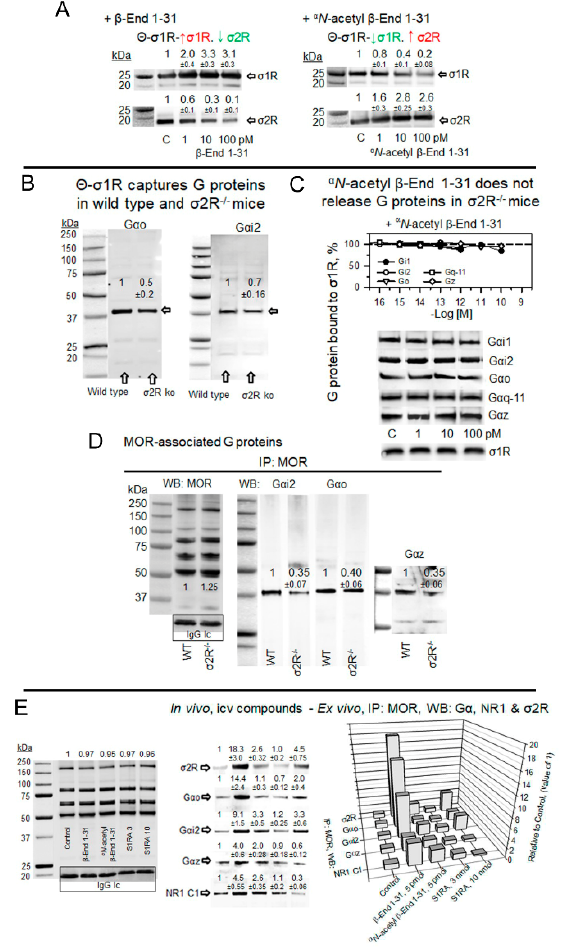
Figure 5. α N ‐ acetyl β‐ End 1–31 promoted and β‐ End 1–31 reduced the exchange of G proteins for Figure 5. α N -acetyl β -End 1–31 promoted and β -End 1–31 reduced the exchange of G proteins for σ 2Rs in σ 1R oligomers. Implications in MOR signaling. ( A ) Effect of β‐ End 1–31 and α N ‐ acetyl β‐ σ 2Rs in σ 1R oligomers. Implications in MOR signaling. ( A ) Effect of β -End 1–31 and α N-acetyl β End 1–31 on the association of σ 1R and σ 2R from mouse cerebral cortex with agarose ‐σ 1R oligo ‐